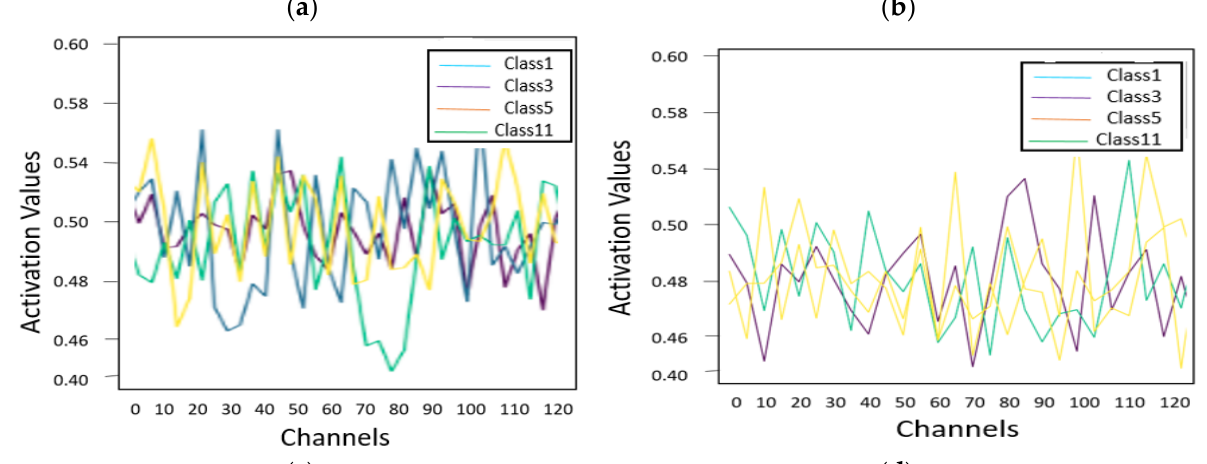
( d ) Figure 15. Illustration of the spatial behavior of four different classes in SE blocks: ( a ) SE-1; ( b ) SE- 2; ( c ) SE-3; and ( d ) SE-4.